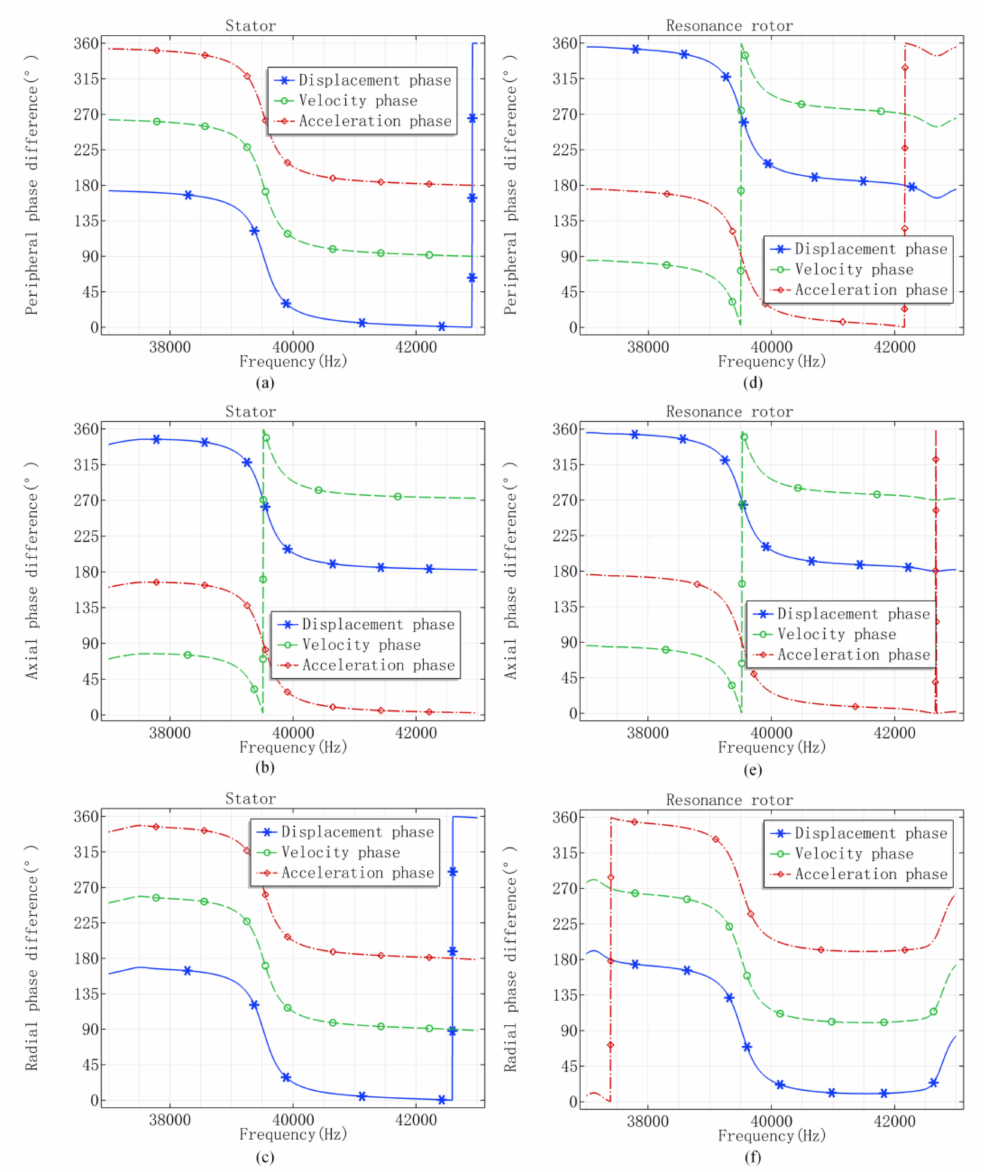
Figure 5. Variation of phase difference of stator and resonance rotor as sweeping frequency. ( a ) Pe- ripheral phase difference of stator. ( b ) Axial phase difference of stator. ( c ) Radial phase difference of stator. ( a ) Peripheral phase difference of resonance rotor. ( b ) Axial phase difference of resonance rotor. ( c ) Radial phase difference of resonance